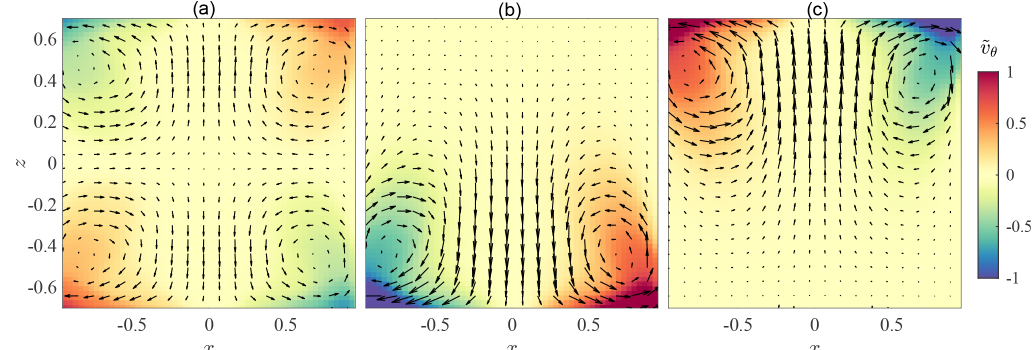
Figure 8. Different states observed in our reduced system – using glycerol – with fewer degrees of freedom. (a) Two-cell symmetric (T) state. (b) One-cell asymmetric (A) state. (c) One-cell asymmetric (B) state. The out-of-plane azimuthal velocity component u φ is shown in colour, while the in-plane radial and vertical speeds (u r ,u z ) are represented by arrows. Fields have been decimated by a factor of 2 for better visibility. The positions x and z are normalized by the radius of the cylinder R .